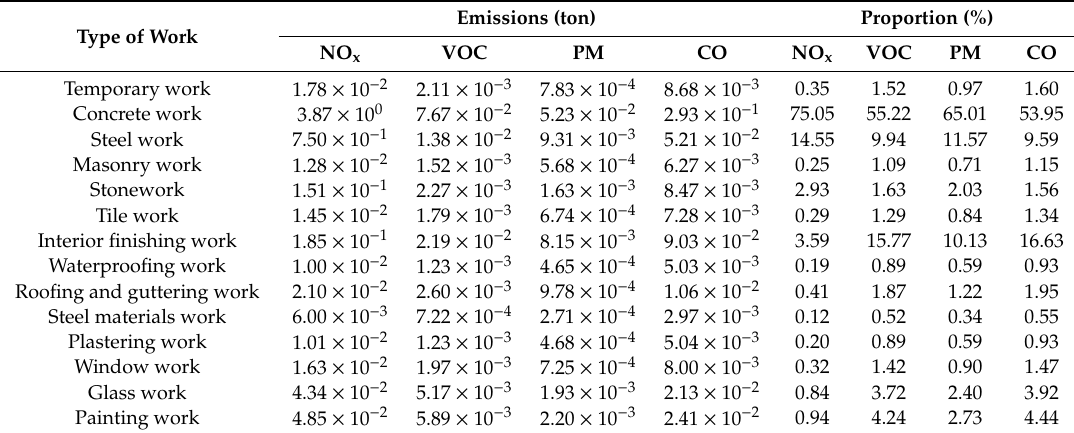
Table 4. Total pollutant emissions of